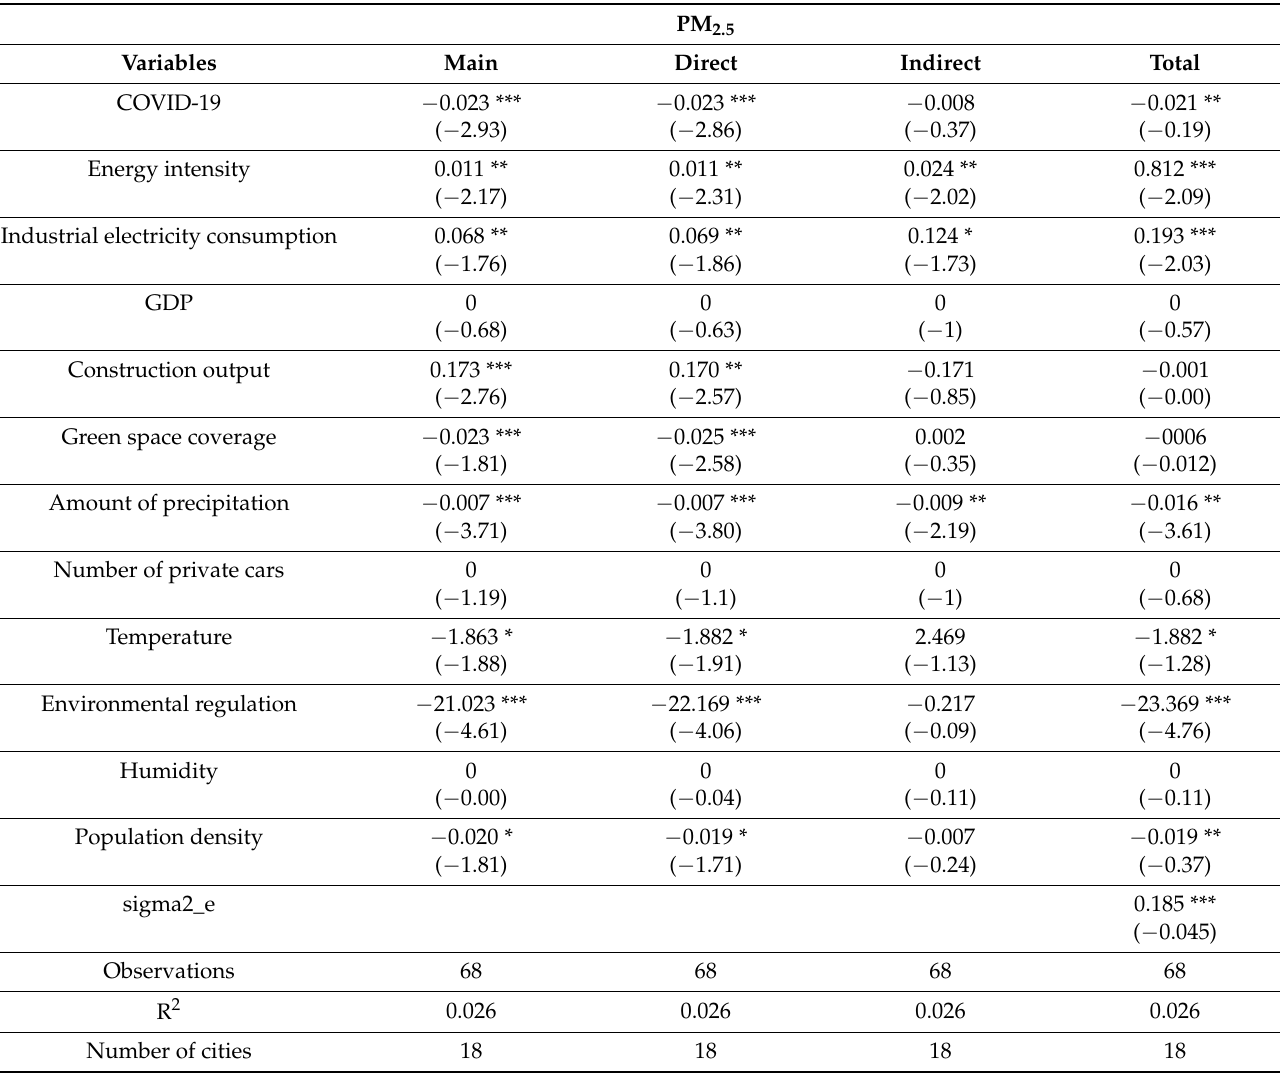
Table 2. Table of the regression results of the spatial Durbin model.